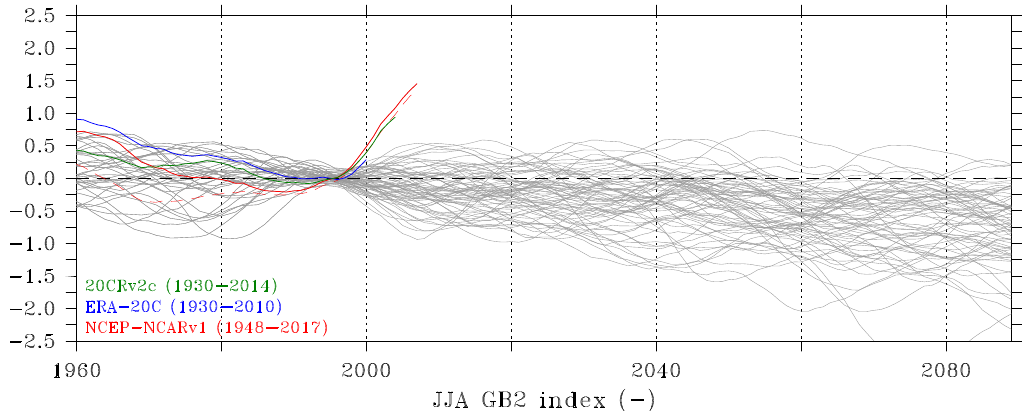
Figure 1. Time series of JJA GB1 (dashed red line) and GB2 (solid red line) indices over 1950–2100 as simulated by NCEP/NCAR Reanal- ysis 1 (red line), by 20CRv2c reanalysis (green line), and by ERA-20C reanalysis in blue as well as by all the CMIP5 models (grey lines) for which both RCP4.5 and RCP8.5 scenarios are available. For the CMIP5-based time series, the historical scenario is used over 1900–2005 and both RCP4.5 and RCP8.5 afterwards. A 20-year running mean has been applied to smooth the time series, and values have been normalised (average = 0 and standard deviation = 1) using 1986–2005 as the reference period.